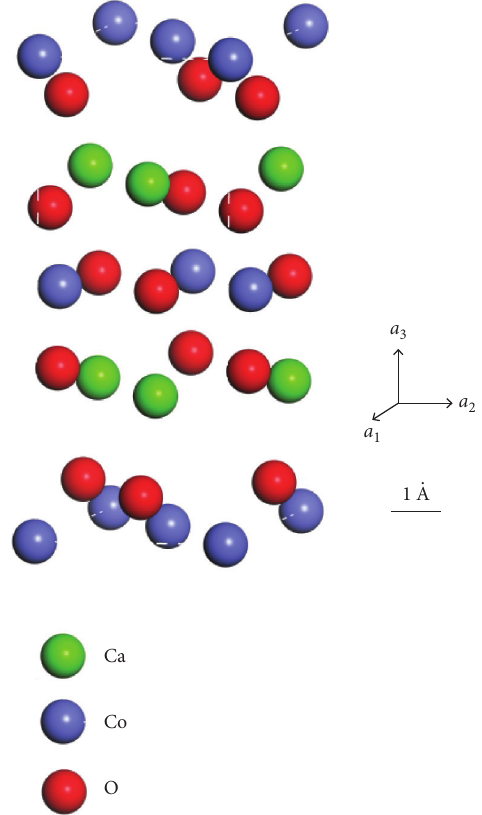
Figure 1: Schematical crystal structure diagram of sandwiched Ca 2 Co 2 O 5 crystalline